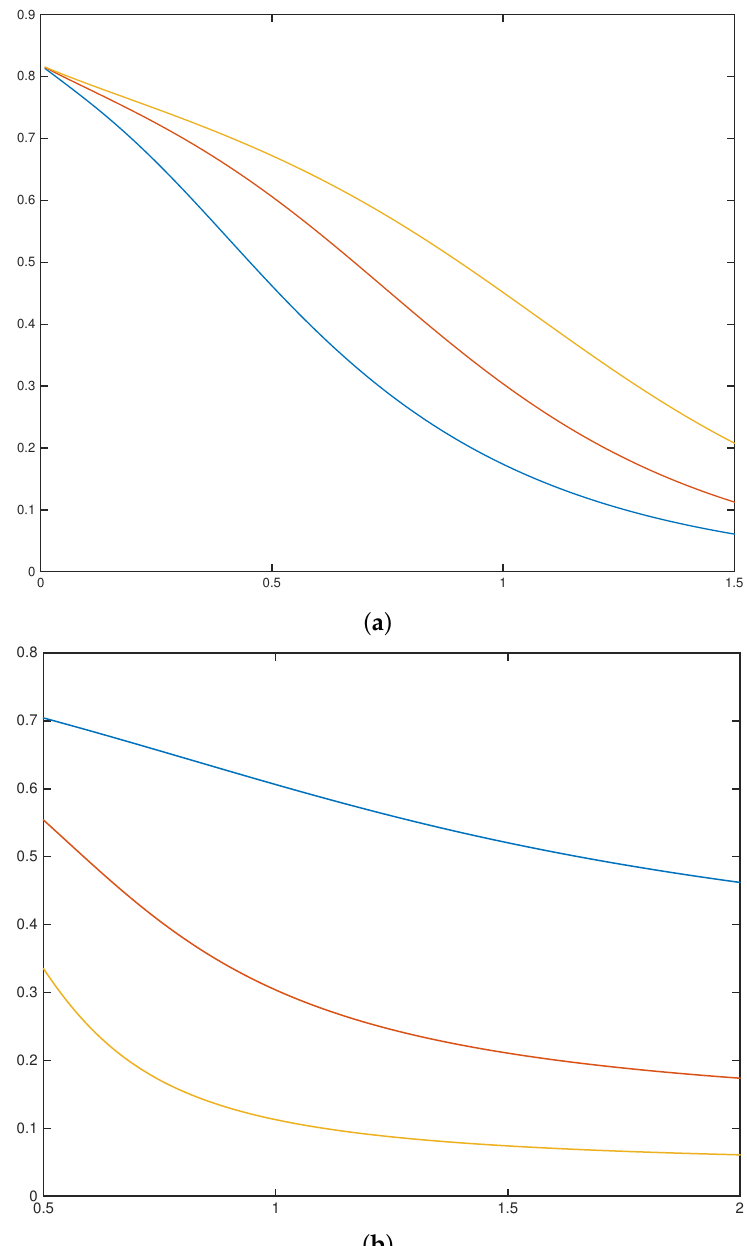
Figure 3. The option price φ 0 ( x ) , x = 2, in the case c 0 = 1, c 1 = 0.5, r = 0.1 : ( a ): versus the switching rate λ = λ 0 = λ 1 , λ ≤ 1.5, for the different values b 0 = b 1 = b = 0.5/1.0/1.5 (from bottom to top); ( b ): versus the mean jump amplitude, m = b − 1 , b = b 0 = b 1 , 0.5 ≤ m ≤ 2, for different switching rates λ 0 = λ 1 = λ = 0.5/1.0/1.5 (from top to